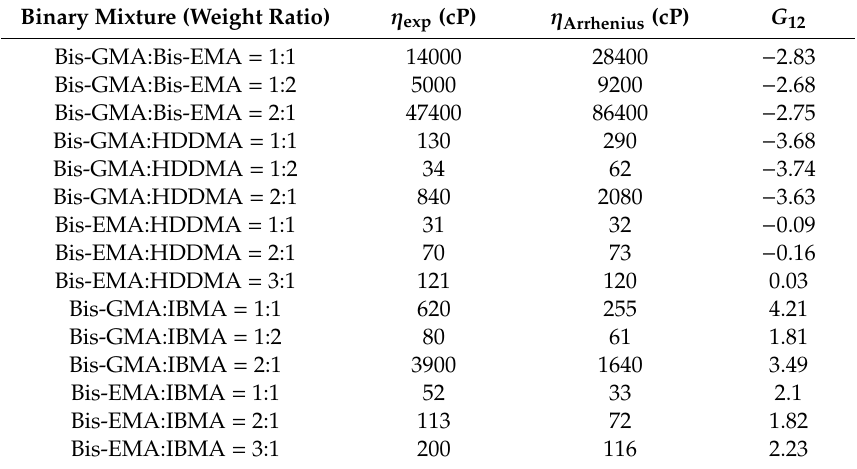
Table A2. The experimental viscosity data of binary resin mixtures, calculated viscosities based on Arrhenius equation, and binary interaction